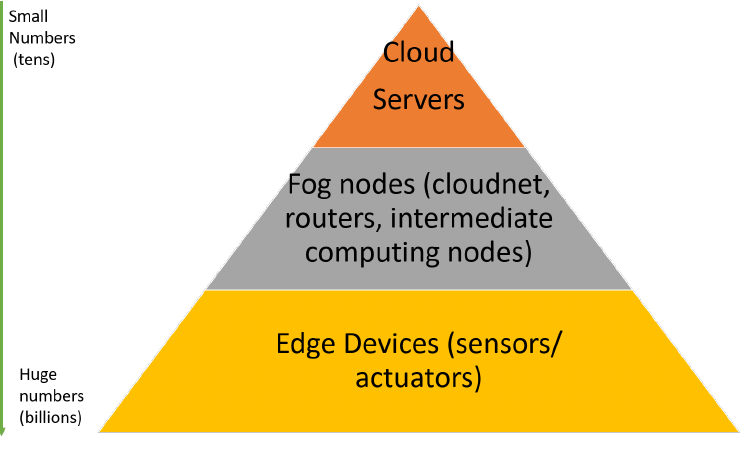
Figure 1. Fog computing